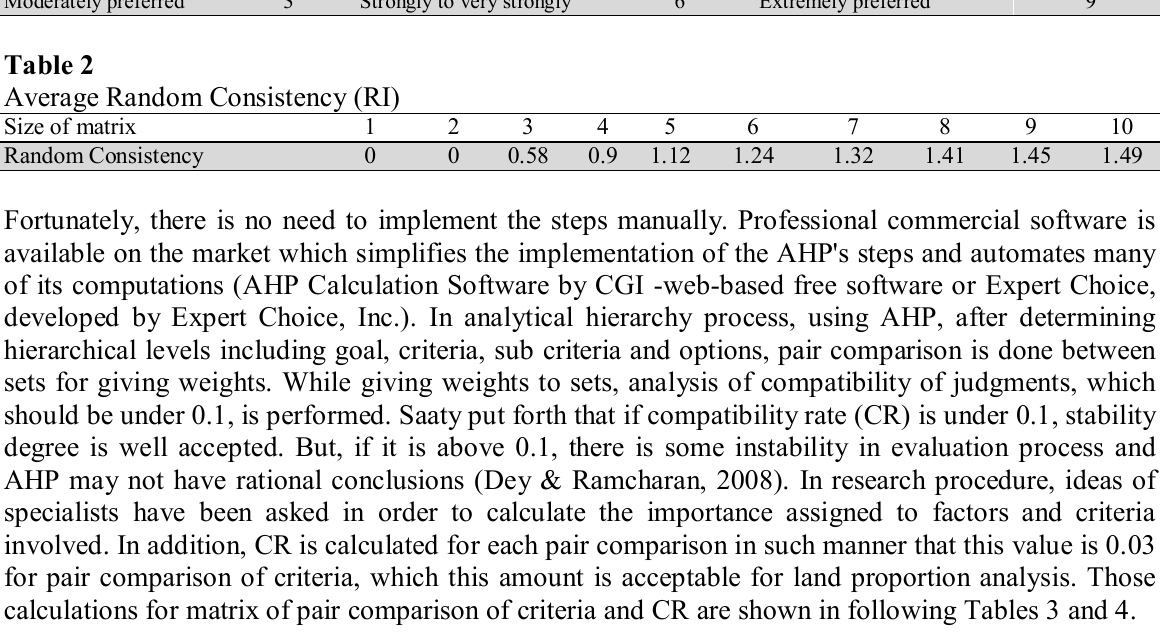
Pair-Wise Comparison Scale for AHP Preferences Judgment Rate Judgment Rate Judgment Rate Equally preferred